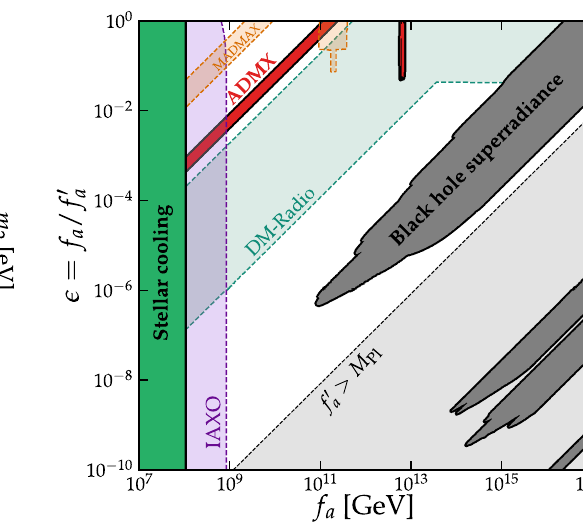
ments, ADMX, and black hole superradiance. Right: as in the left-hand panel, but now showing projected constraints from future experiments: MADMAX [58], IAXO [59] and DMRadio/ABRACADABRA [60,61]